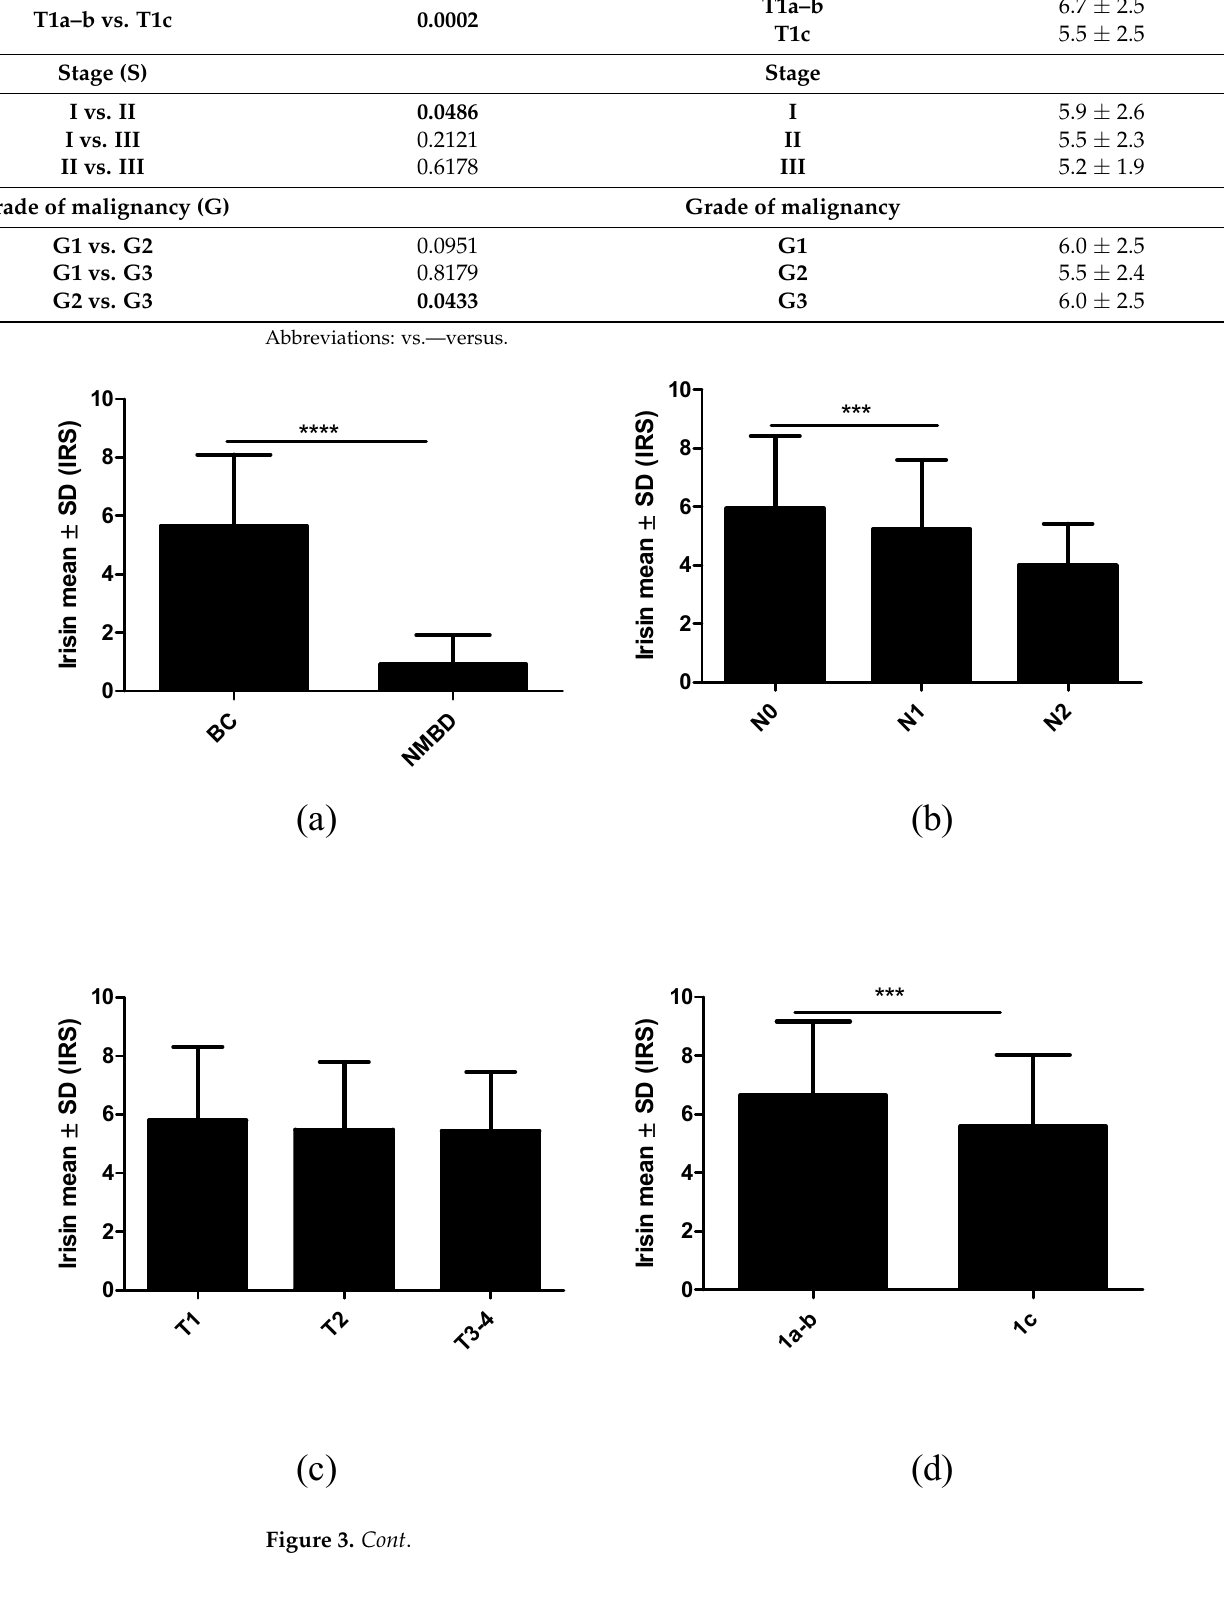
Figure 3. Comparison of irisin expression levels using immunohistochemistry (IHC) in breast cancer (BC) patients and control tissues ( a ) according to the lymph node status ( b ), tumor size ( c – d ), tumor stage ( e ), and malignancy grade ( f ). * p < 0.05, *** p < 0.001, **** p < 0.0001.